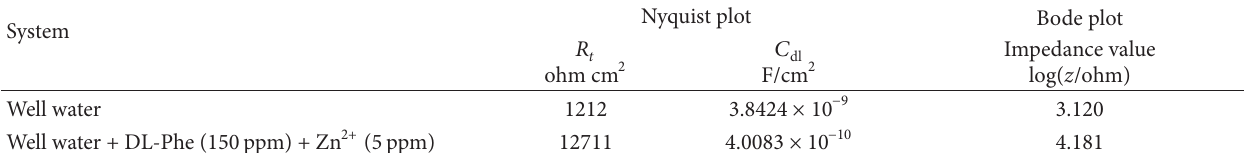
T 6: Corrosion parameters of carbon steel immersed in well water in the absence and presence of inhibitor system obtained from AC impedance spectra (pH = 8).